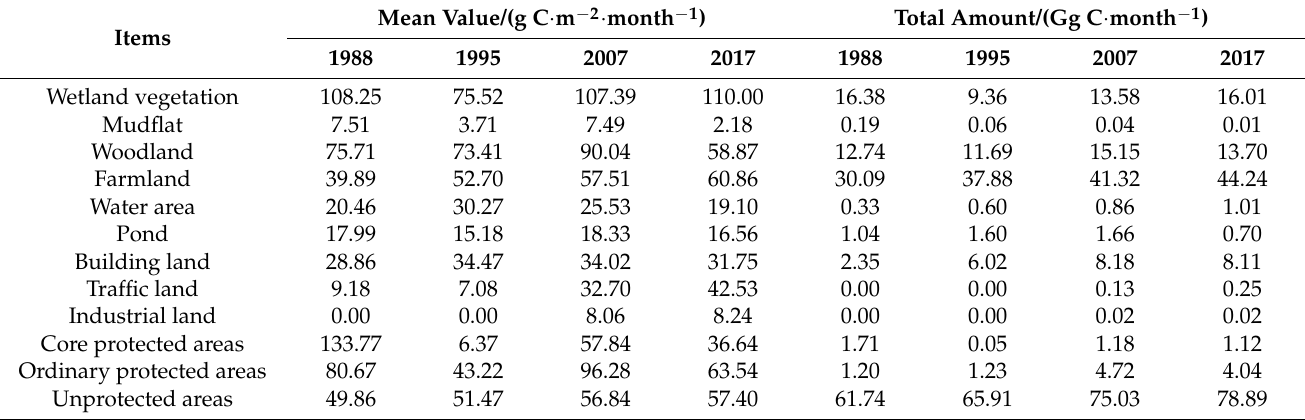
Table 2. NPP results of different land-cover and protected area types in the last 30